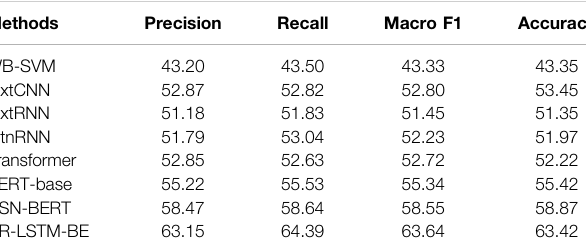
TABLE 2 | Performance on the COVID-19 rumor twitter dataset.